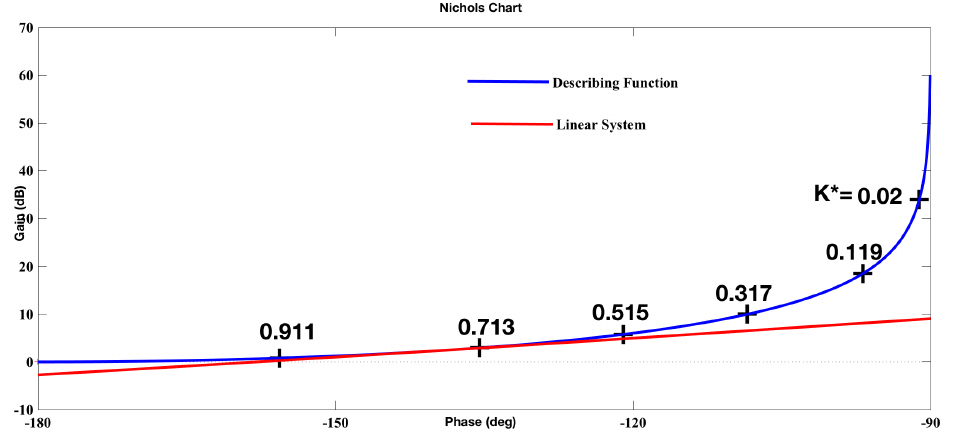
Figure 19. Nichols plot of “Phastball” with respect to describing function after pilot gain